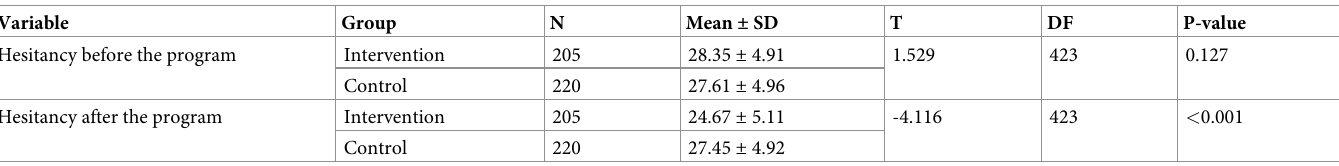
Table 2. Hesitancy of getting the vaccine between the intervention group and the control group.